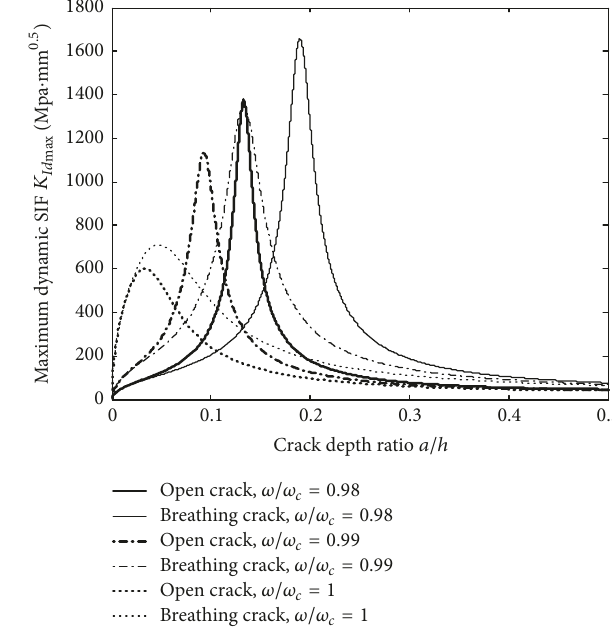
Figure 11: The maximum dynamic SIF with crack severity change for different frequency ( 𝜇 = 0 ).